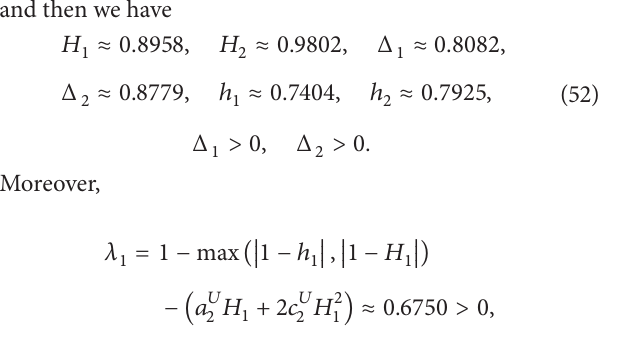
(𝑛) and 𝑥 (𝑛) with initial values 𝑥 ∗ 2 2 (0) = 0.97 for 𝑛 ∈ [0,100] , 2